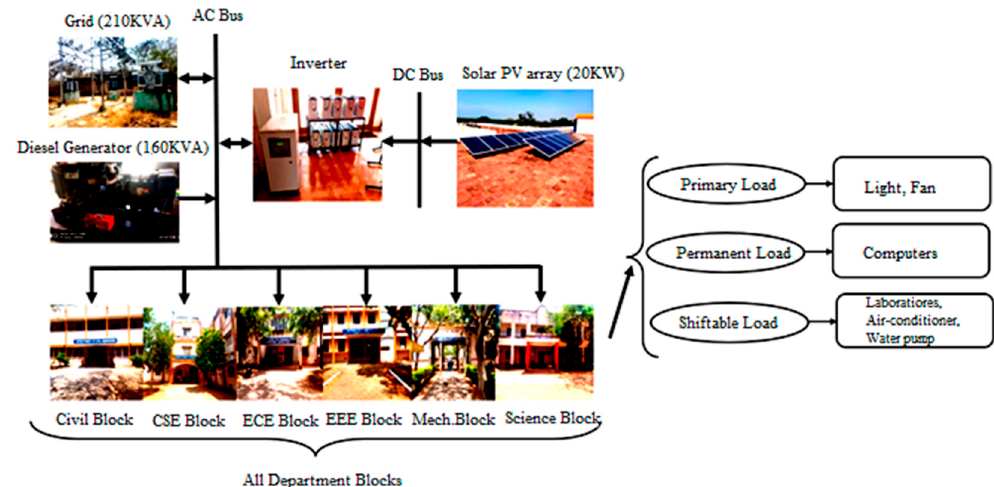
Figure 3. Load assumption for demand-side management (DSM).